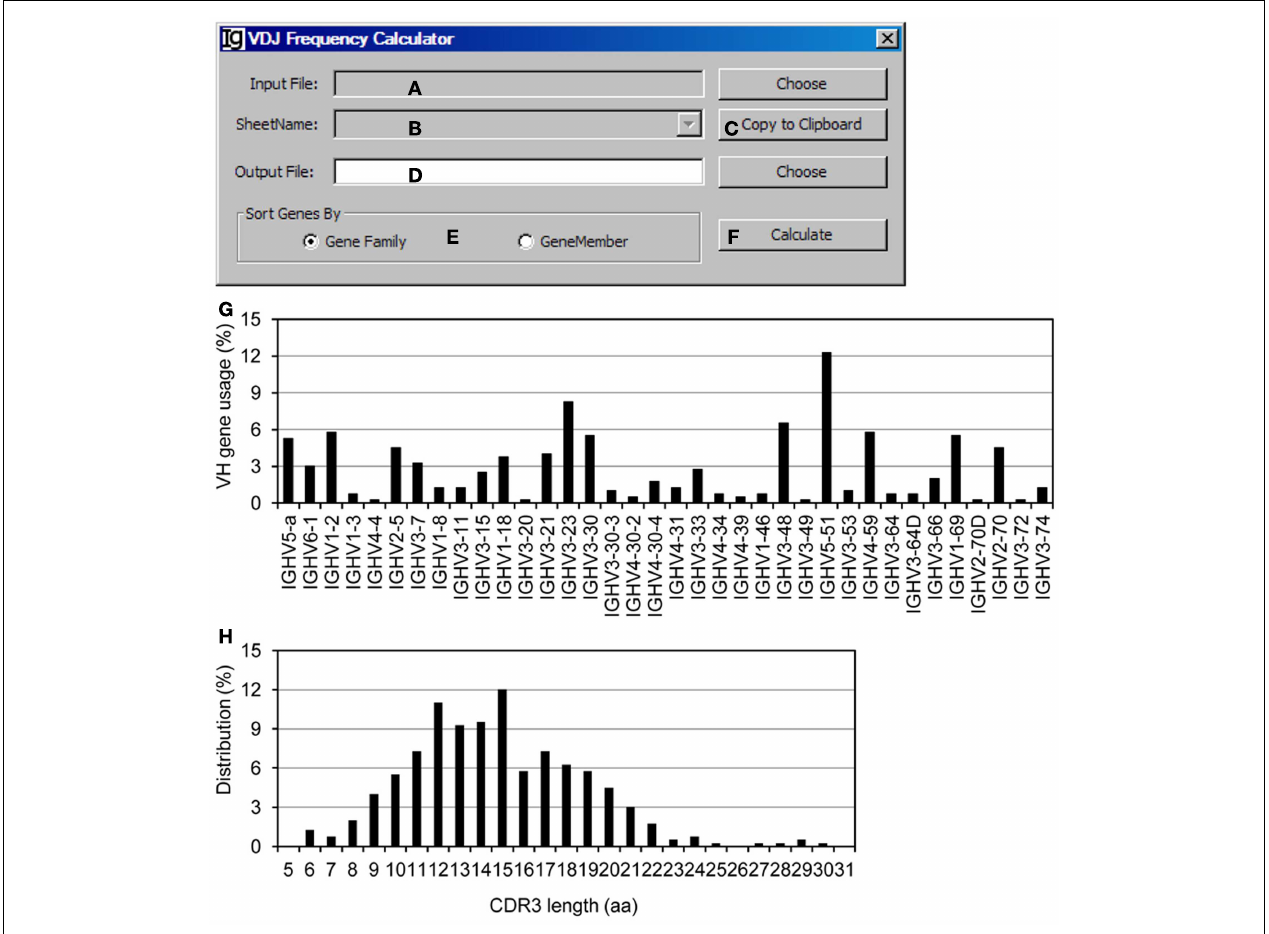
FIGURE 10 |TheVDJ frequency calculator . Diagram shows the interface of theVDJ Frequency Calculator. (A) Button to select the input footprint analysis result file. (B) Combo box for selecting the sheet for processing, when an Excel file is selected as the input file. (C) Button to copy the value in (B) to clipboard. (D) Button to choose the output file. (E) Radio button group to select the sorting criterion for the output results. (F) Button to start the calculator. (G) The output results ofV H gene usage in the test sequences were presented as a bar graph. (H) Distribution of the Z417 test IgH gene sequences with different CDR3 lengths.